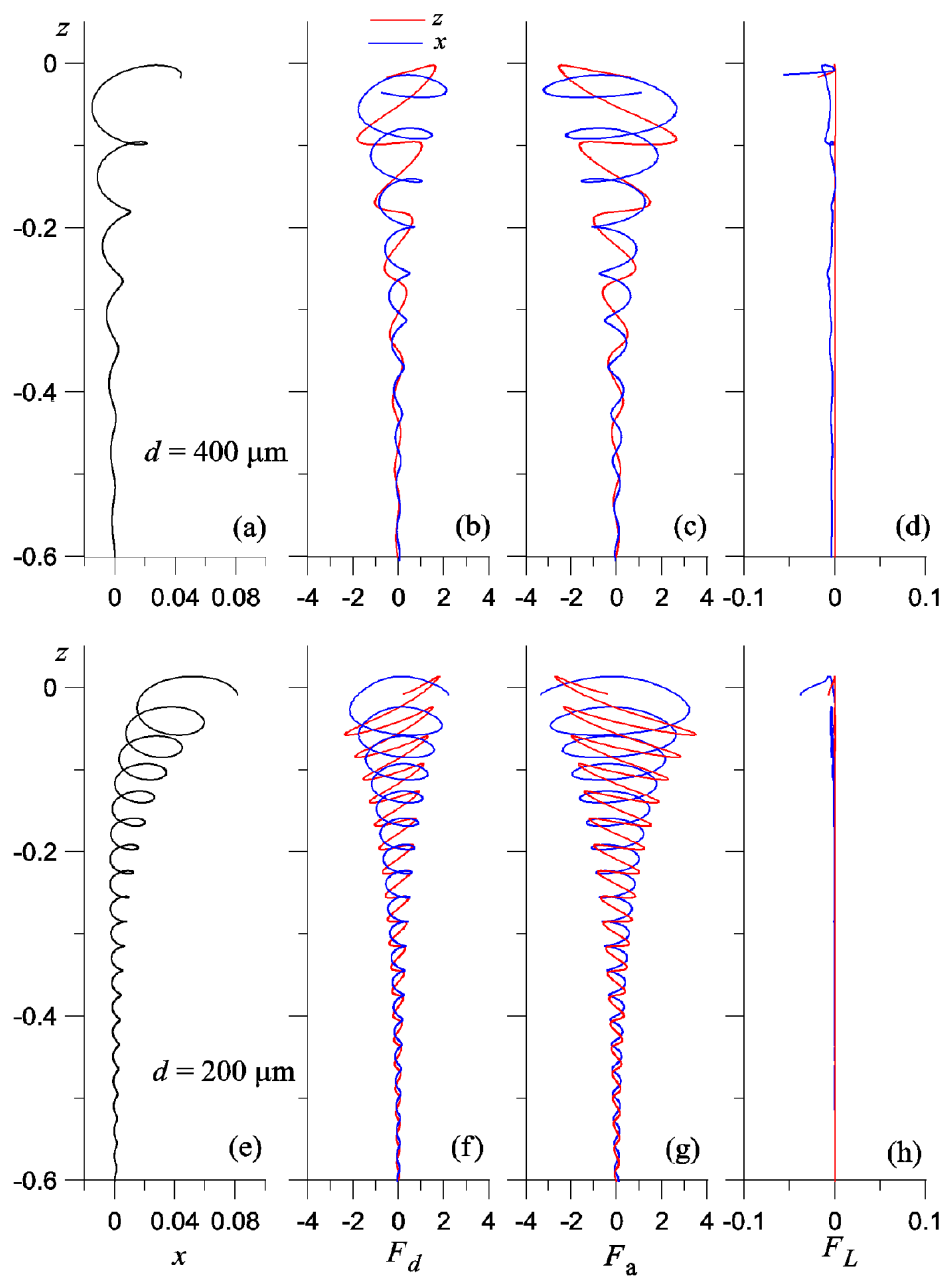
Figure 5. Trajectories of individual bubbles ( a , e ) and x and z components of forces imposed on the bubble by the surrounding water [drag F d ( b , f ); fluid acceleration F a ( c , g ); lift F L ( d , h )] obtained using DNS without surface-induced wind drift, U d = 0. Top and bottom panels are for the bubble diameter d = 400 and 200 µm, respectively. Wave slope ka = 0.2. For convenience, in panels ( b , f ) the mean value of the z -component of F d is subtracted.